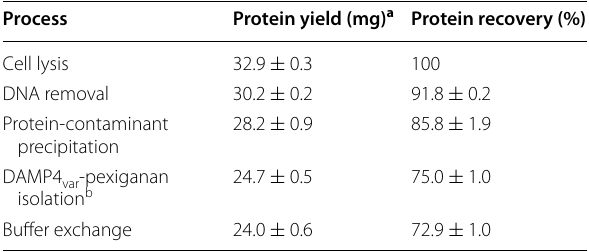
Table 1 Mass balance of the downstream processing of DAMP4 -pexiganan protein var